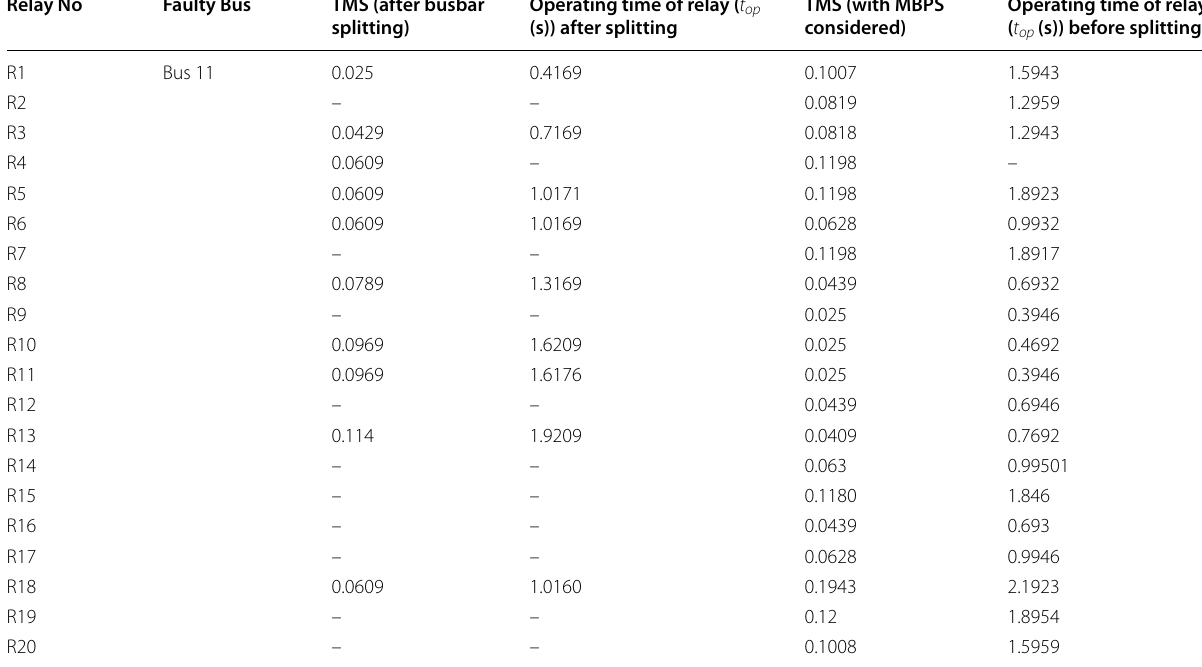
Table 5 TMS and t op of all relays before and after splitting in the IEEE 14-bus system Relay No